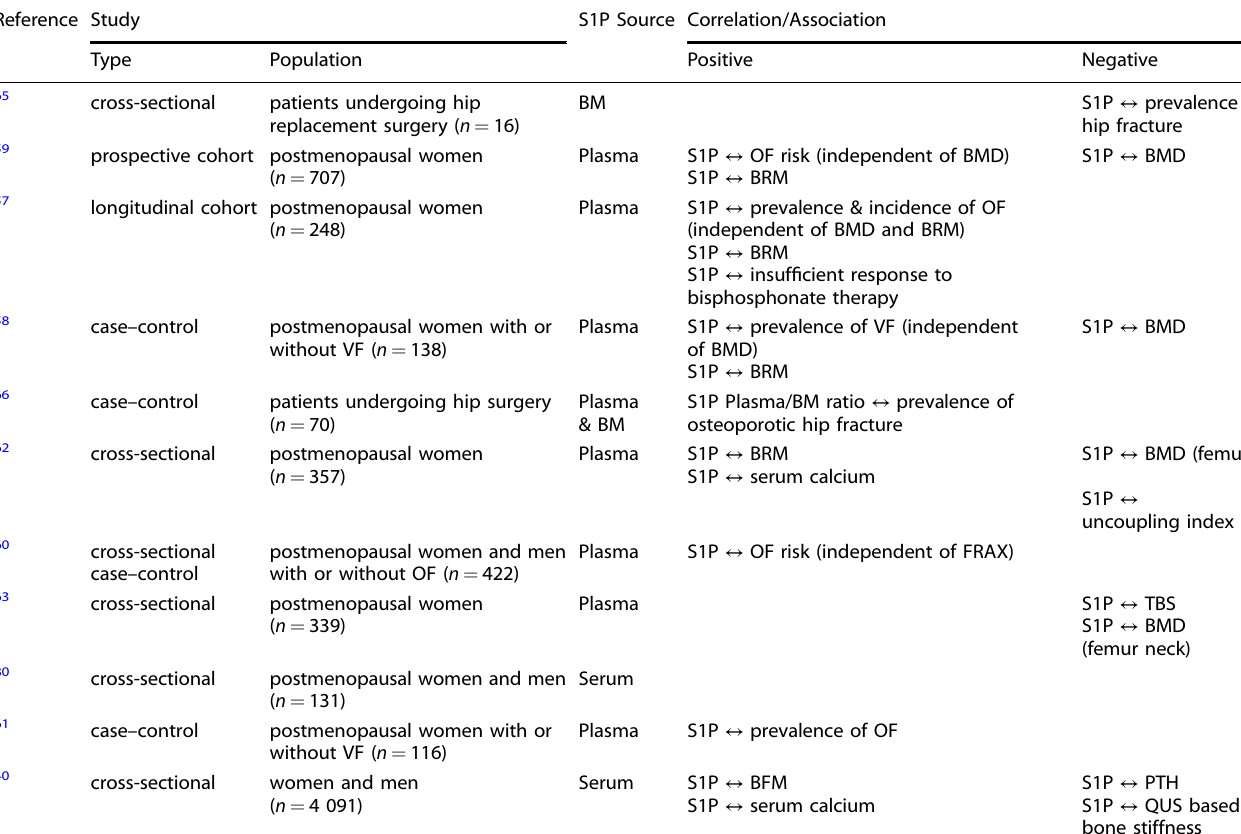
Table 1. Role of sphingosine-1-phosphate levels as biomarkers for osteoporosis Reference